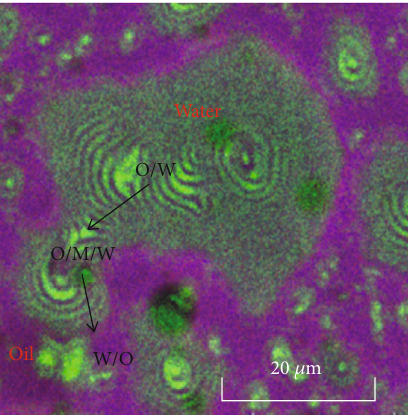
Figure 17: Emulsion transformation